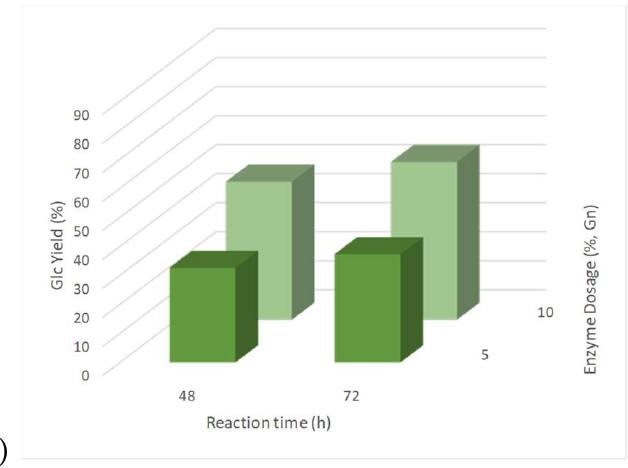
Figure 11. Effect of enzyme dosage and reaction time on the enzymatic saccharification of eucalyp- tus residues ethanol–water organosolv pulp obtained at 190 °C without ( a ) and with 50 mM acetic acid ( b ) or 140 °C and with 50 mM sulphuric acid as catalyst ( c ).